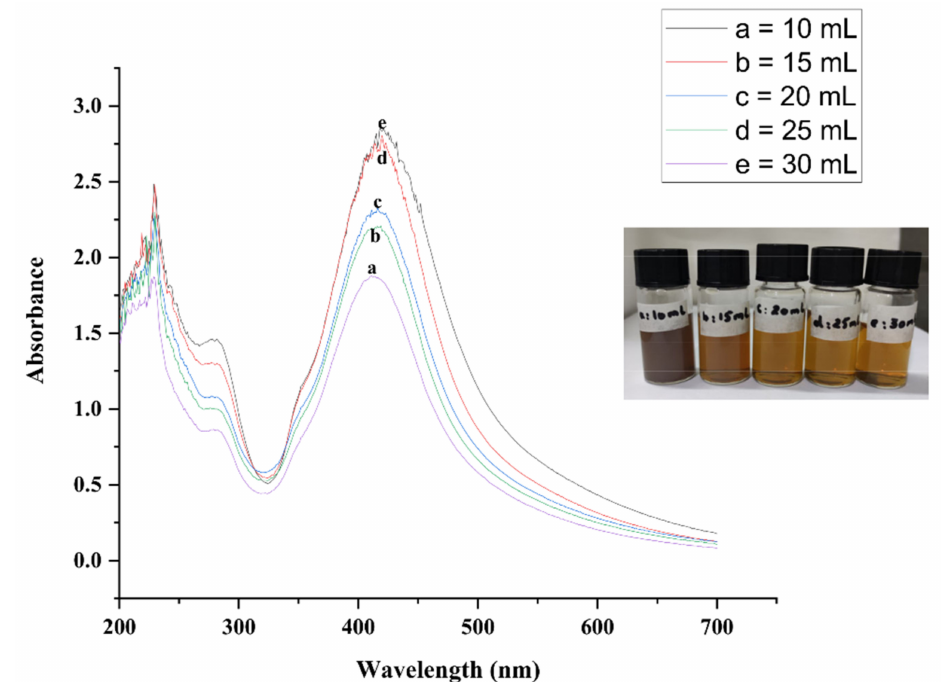
Figure 4. UV-Vis spectra taken against different volumes of NaBH 4 against the same volume of arbutin and AgNO 3 solutions.